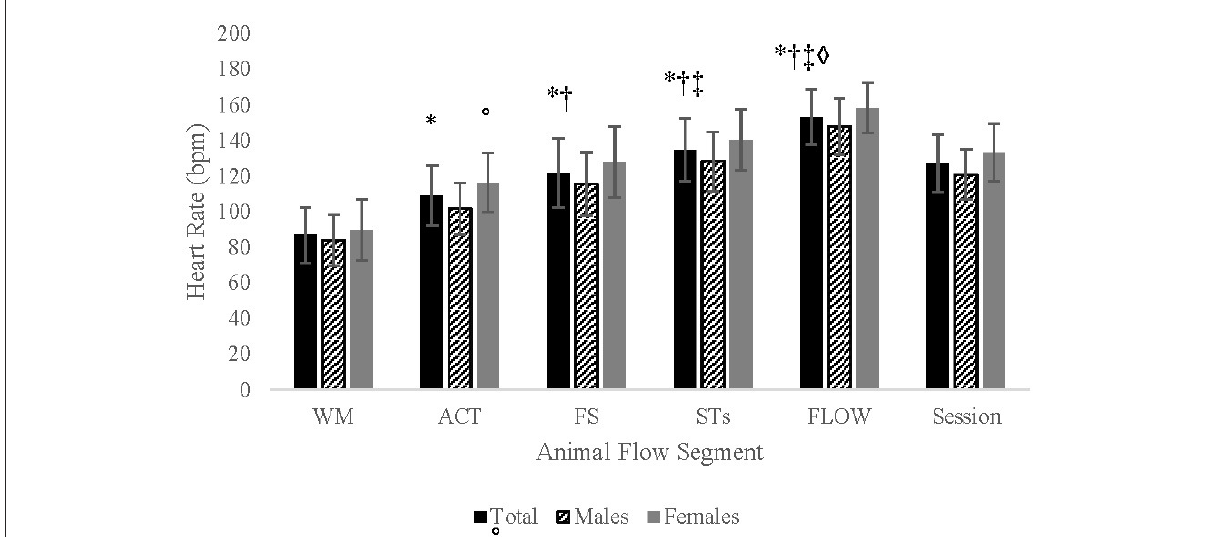
FIGURE4 Heart rate comparisons between Animal Flow segments. Data are Mean ± SD. WM, wrist mobilizations; ACT, activations; FS, form stretches; STs, switches and transitions; FLOW, choreographed flow; *significantly greater than WM; † significantly greater than ACT; ‡ significantly greater than FS; ♦ significantly greater than STs; ◦ females significantly greater than